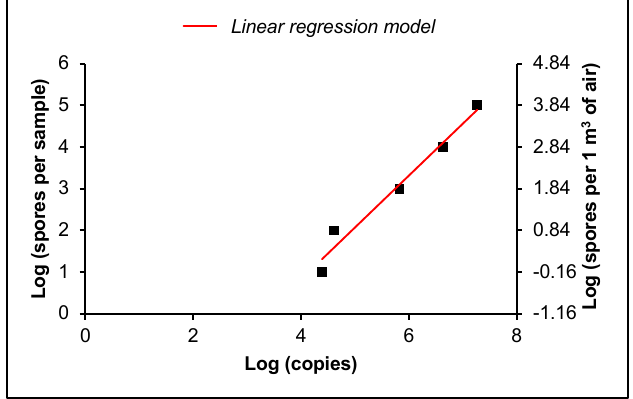
Figure 2. Standard curve of the number of ascospores of H. fraxineus in logarithmic scale and the corresponding numbers of copies of the target sequence in 1 µL of template DNA in logarithmic scale (left) accompanied by atmospheric concentration sampled by SAVST (in logarithmic scale as well).